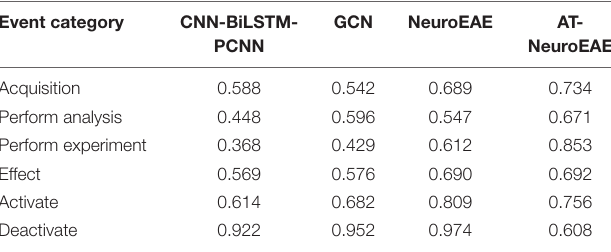
TABLE 6 | F 1 values of event